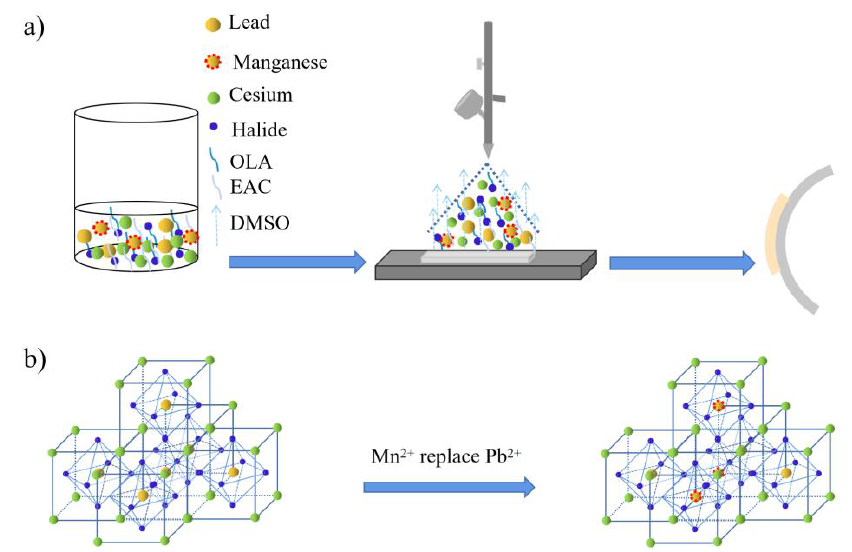
Figure 1. ( a ) The schematic diagram of solution spraying process; ( b ) Mn 2+ replaced part of Pb 2+ . The PL spectra of CsPbBr 3 and CsPb x Mn 1 − x (Br,Cl) 3 films were shown in Figure 2a. For CsPbBr 3 film, an emission band centered at 515 nm is observed, while the peaks at 450/470 nm could be attributed to EAC. When doped with MnCl 2 , two peaks at around 509/616 nm were observed. It was found that the main peak of 515 nm in pure CsPbBr 3 film gradually blue-shifted to 505 nm with the ratio of PbBr 2 :MnCl 2 increasing from 3:1 to 1:1. This may be caused by the band gap varying, which resulted from the increasing Br-to-Cl exchanging after MnCl 2 incorporation [22,32]. The peak locating at 616 nm was derived from the energy transferring of 4 T 1 → 6 A 1 caused by Mn substitution for Pb in CsPb x Mn 1 − x (Br,Cl) 3 material. In CsPb x Mn 1 − x (Br,Cl) 3 , after band to band optical excitation, the Mn 2+ emission slightly red-shifted from 616 nm to 619 nm as the Mn ratio